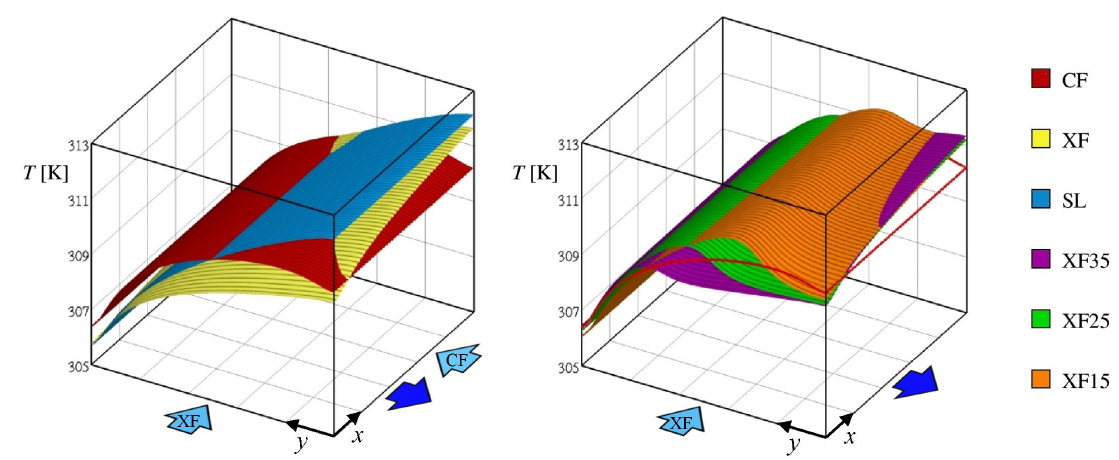
Figure 5. Bottom wall temperature distributions for six MCHS configurations and ˙ V = 10.0 mL/s (dark blue arrow: bottom layer; light blue arrow: top